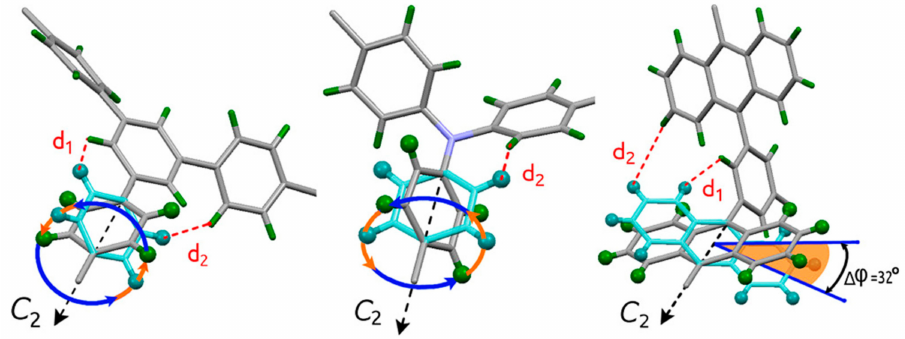
Figure 7. Illustration of aromatic ring linker rotation for isostructural (3,24)-connected porous materials, MFM-112a, MFM-115a, and MFM-132a, with di ff erent linker backbone functionalization [88].